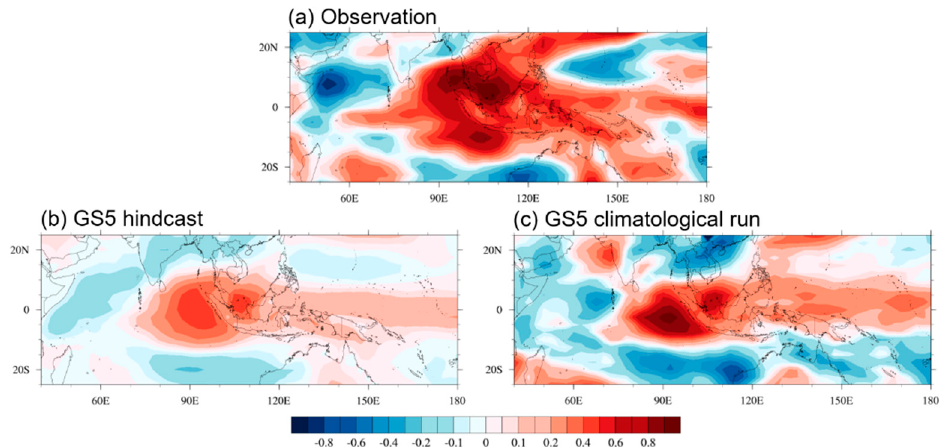
Figure 7. The regressed 20–70-day filtered 850 hPa equivalent potential temperature (EPT; °C) onto filtered precipitation (20–70 days) averaged over the eastern Indian Ocean (10° S–10° N, 80°–100° E) from ( a ) observation, ( b ) GS5 hindcast data, and ( c ) GS5 climatological run. The strengths of regression are fixed to a 3 mm day − 1 .